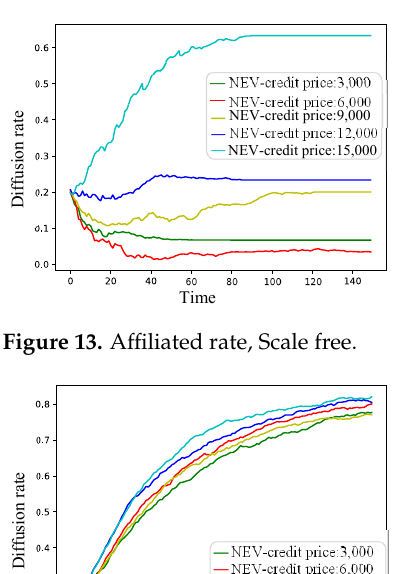
Figure 12. Sale profit, Small world.